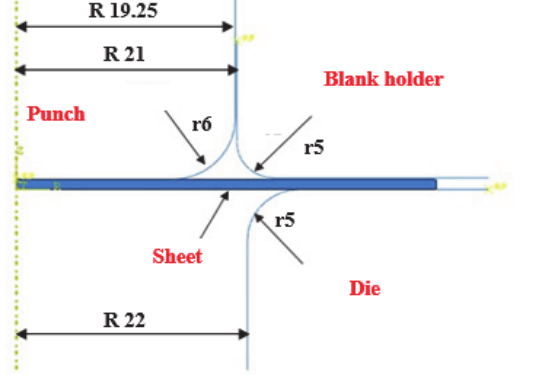
Fig. 2. The geometrical dimensions of the die set (in mm)